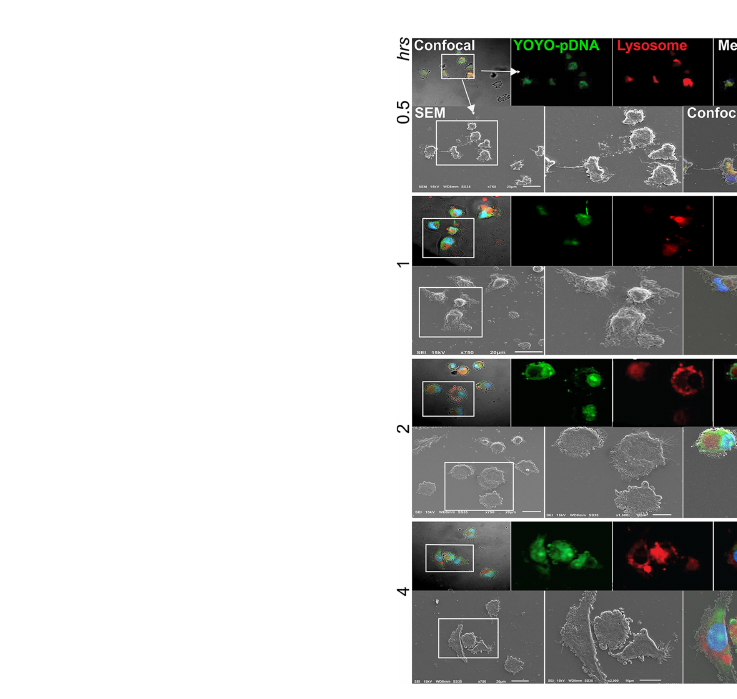
FIGURE 5 | Intracellular traf fi cking and nuclear ingress of YOYO-IL-4pDNA/NPs. Co-imaging of confocal microscopy and SEM were taken of MDM transfected with YOYO-IL-4pDNA-NPs at 0.5, 1, 2 and 4 hours. Lysosomes were labeled with LysoTracker (red) and nuclei were labeled with DAPI (blue). For each time point, the confocal (upper panel) images were taken before scanning with the SEM (lower panel). Co-images are shown in the lower panel (confocal + SEM). YOYO-IL-4pDNA- NPs were internalized in MDM cells at 0.5 hours. The escaped YOYO-IL-4pDNA-NPs from lysosomes were seen at 1 and 2 hours, and condensed in the nucleus by 2 hours post transfection. By 4 hours, greater cytoplasmic levels of YOYO-IL-4pDNA-NPs were detected again, indicating continual intracellular accumulation within the cell